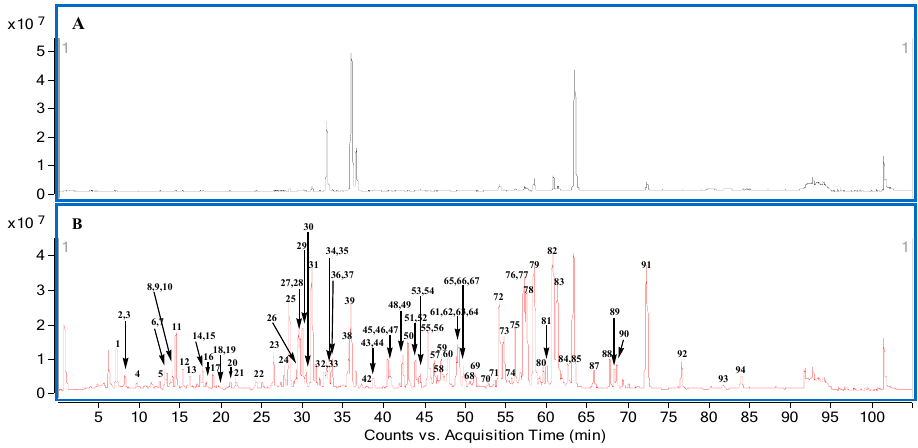
Figure 8. The total ion chromatograms of UHPLC-Q-TOF/MS in negative mode.